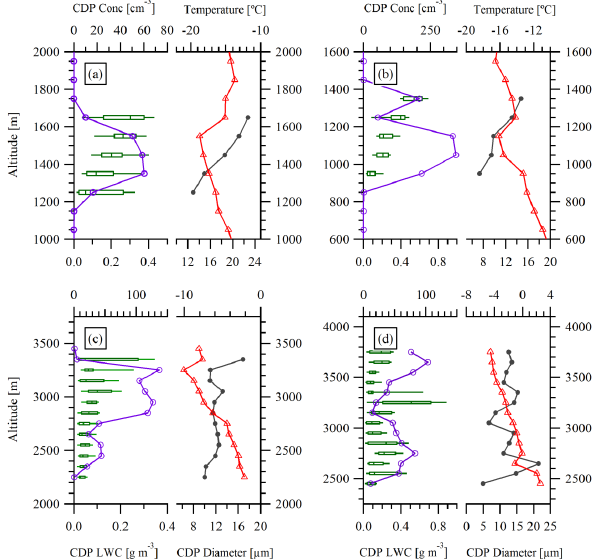
Figure 10. Percentile plots (50th, 25th, 75th percentiles, whiskers to 10 and 90%) as a function of altitude for LWC from CDP (green), and median droplet number concentration (purple), median droplet diameter (grey) and median temperature (red). Data are averaged over 100m deep layers. (a) – (d) are for spring case 1, spring case 2, summer case 1 and summer case 2, respectively.